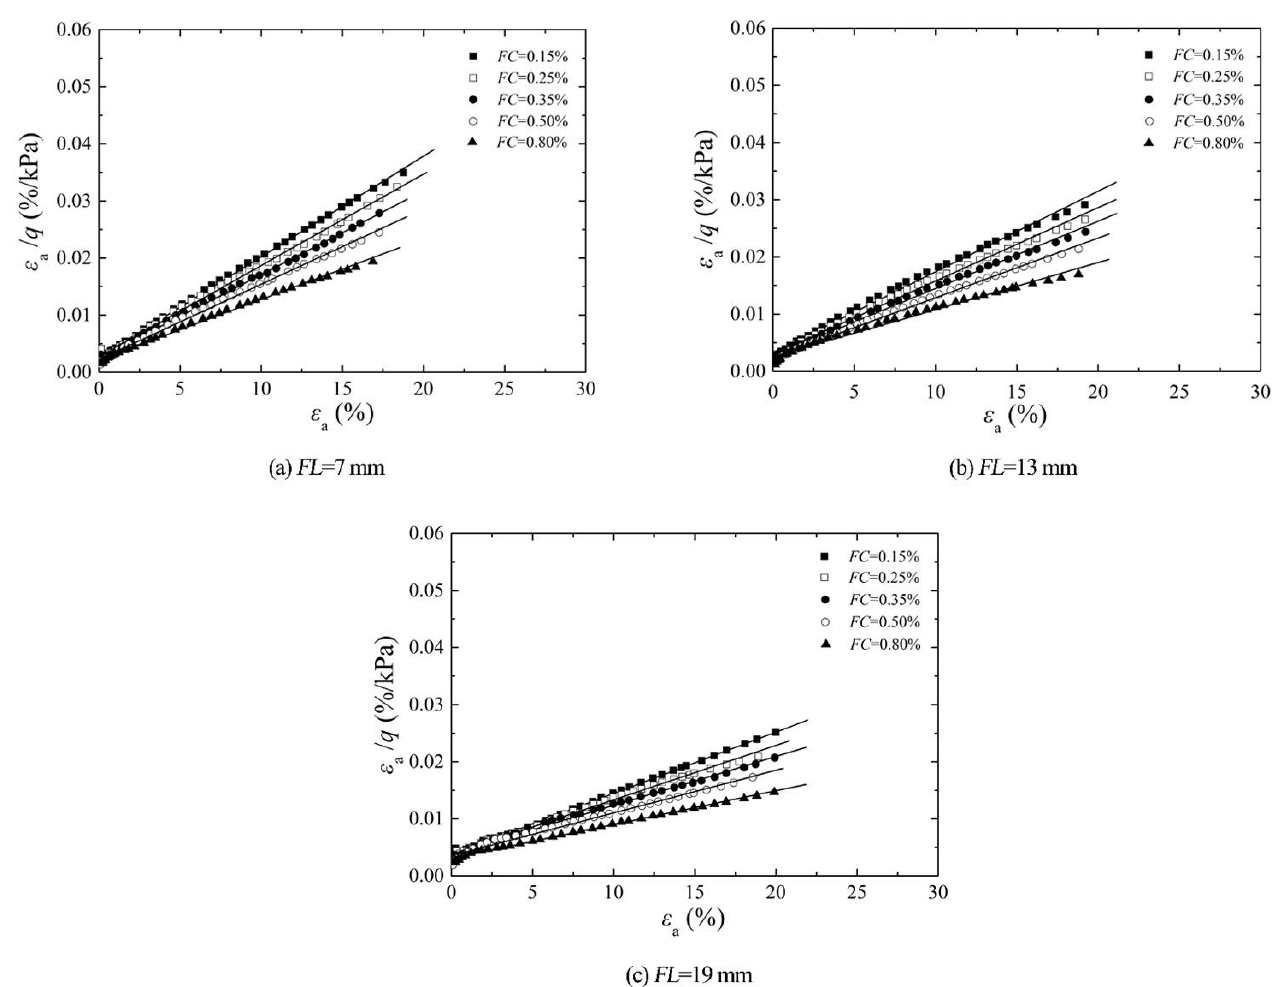
Figure 5. Fitting of the measured results ( σ 3 = 200 kPa).